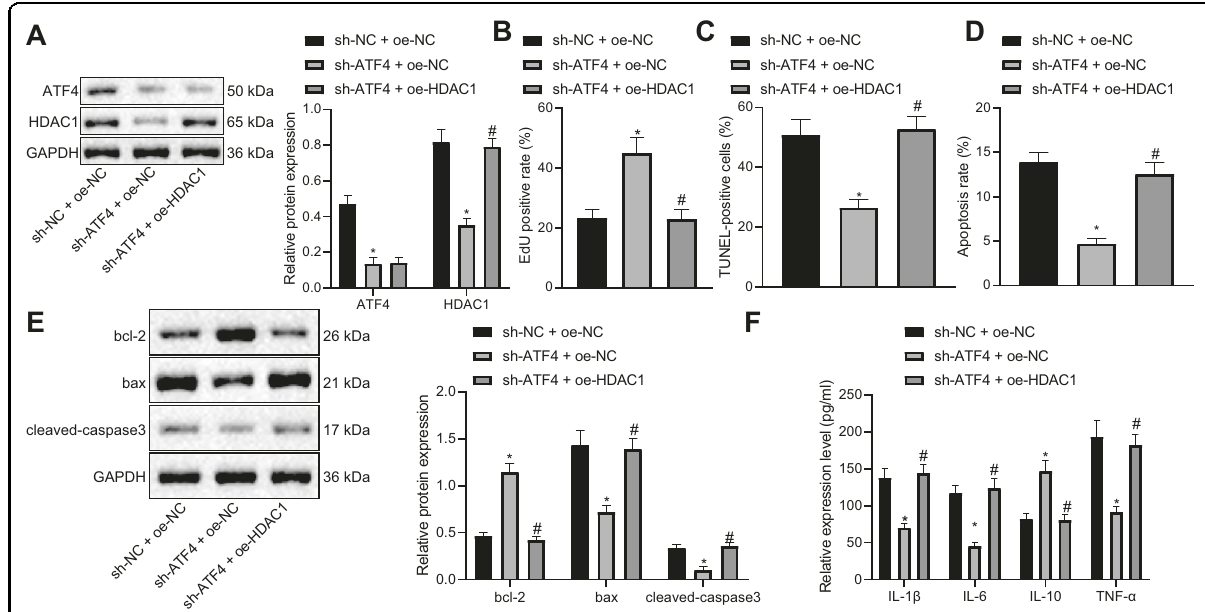
Fig. 4 Silencing ATF4 inhibits apoptosis of pancreatic acinar cells by downregulation of HDAC1 expression. A Western blot analysis was performed to detect ATF4 and HDAC1. B EdU was applied to detect pancreatic acinar cell proliferation after sh-ATF4 or oe-HDAC1 treatment. C TUNEL was performed to detect pancreatic acinar cell apoptosis after sh-ATF4 or oe-HDAC1 treatment. D Flow cytometry was performed to detect pancreatic acinar cell apoptosis after sh-ATF4 or oe-HDAC1 treatment. E Western blot analysis was performed to detect expression of Bcl-2, Bax and cleaved-caspase3. F ELISA was conducted to test levels of IL-1 β , IL-6, TNF- α , and IL-10. * p < 0.05 compared with the sh-NC + oe-NC group; # p < 0.05 compared with the sh-ATF4 + oe-NC group. The comparison of the measurement data (mean standard ± deviation) among multiple groups was analyzed by one-way analysis of variance with Tukey ’ s post hoc